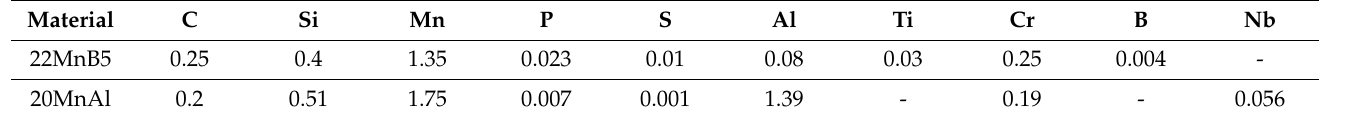
Table 1. Chemical composition of the materials (wt. %).